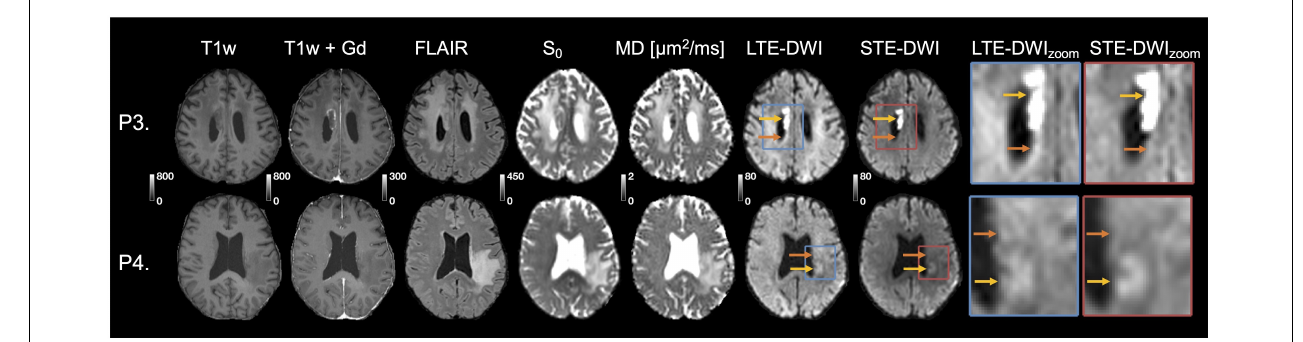
FIGURE 4 | Tumor-related hyperintensities obscured by white matter. The top row (patient P3) shows images obtained to evaluate radionecrosis in a female (69 years old) diagnosed with anaplastic astrocytoma of grade III (wild-type IDH). The periventricular white matter (orange arrow) surrounding the tumor-related hyperintensity (yellow arrow) is visible with LTE-DWI, but is attenuated with STE-DWI. The hyperintensity is more clearly delineated with STE-DWI. The second row (P4) shows images obtained to confirm tumor progression in a female (71 years old) diagnosed with glioblastoma grade IV [methylated; O6-methylguanine-DNA methyltransferase (MGMT)]. A tumor-related hyperintensity (yellow arrow) can be seen with similar intensity as the surrounding white matter on LTE-DWI. With STE-DWI, the hyperintensity stands out more clearly (orange arrows) and could be missed out if only the LTE-DWI is inspected.